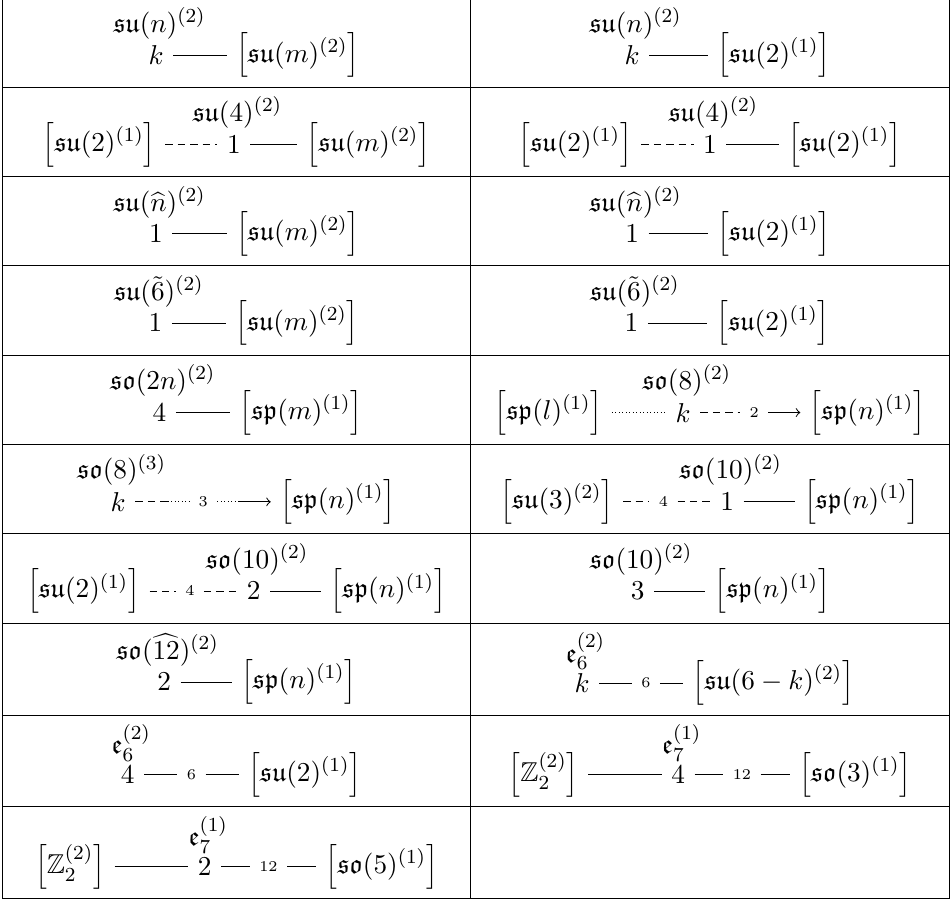
Table 7 . Possible localized flavor symmetries for gauge-theoretic nodes in 5 d KK